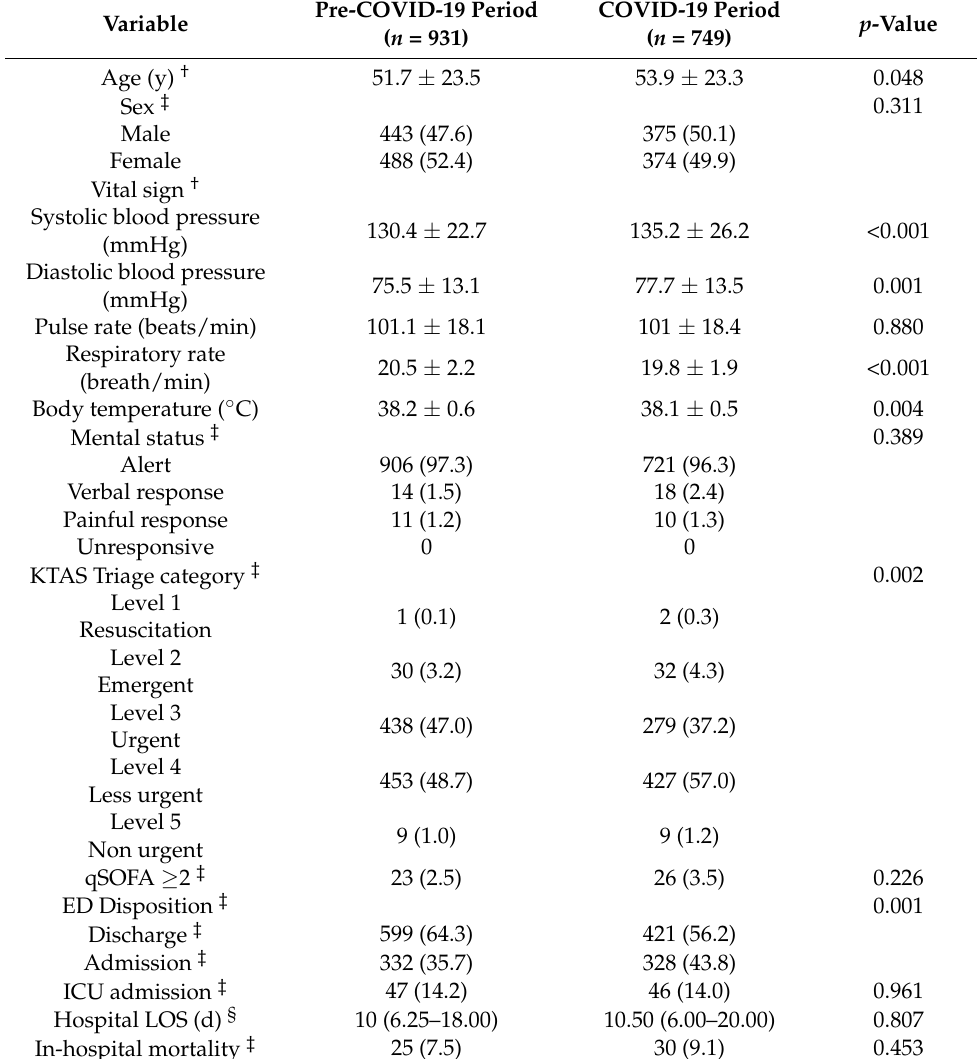
Table 1. The characteristics of adult patients by the pre- and COVID